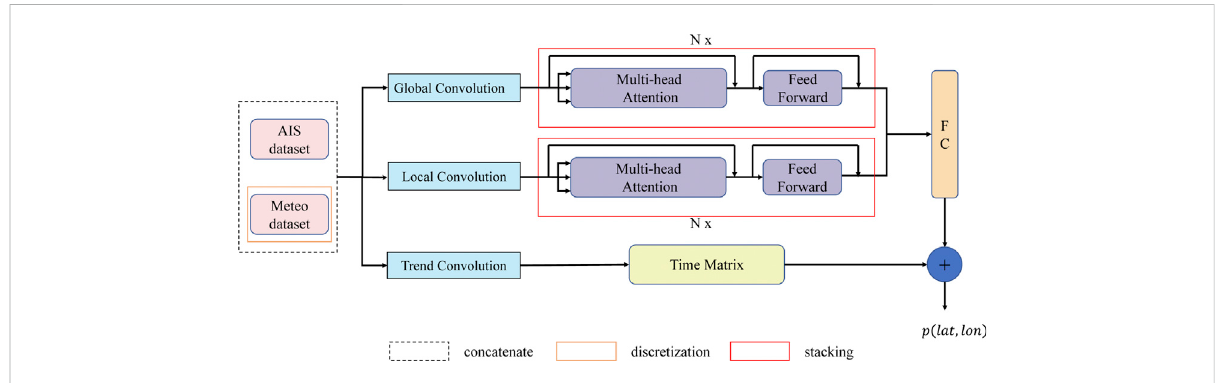
FIGURE 6 Network structure of TripleConvTransformer.